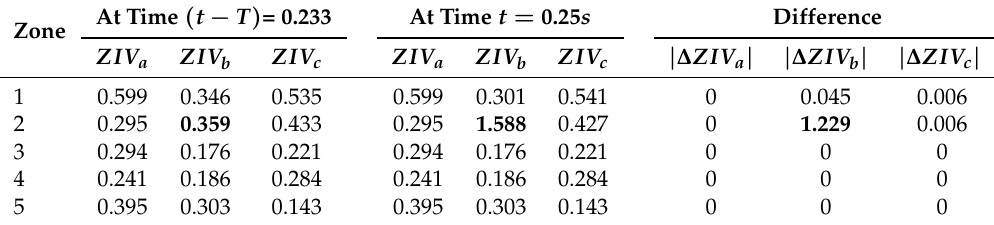
Figure 5. Measurements transmitted by the edge device with and without the use of context aware policy in edge device for sensor 2. Table 1. | ∆ ZIV | vectors for phase a,b,c for test case 1 at time t= 0.25 s. (The value shown in bold face indicates phase B fault in zone 2. All the values are calculated in